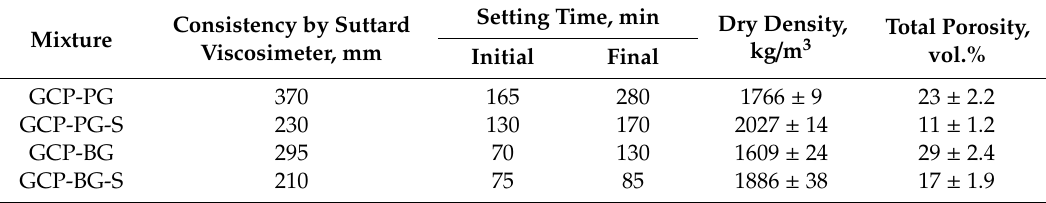
Table 4. Physical properties of high-performance ternary system binder.